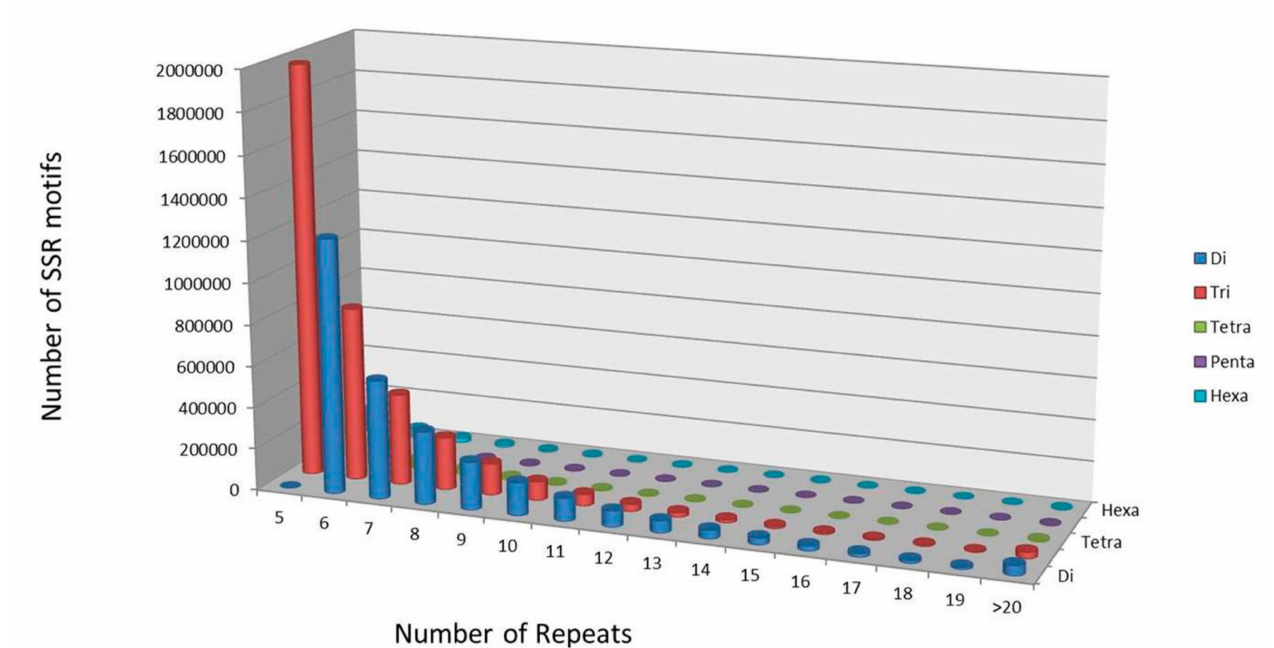
Figure 3. Motif and repeat abundance in fungal whole genome based SSR